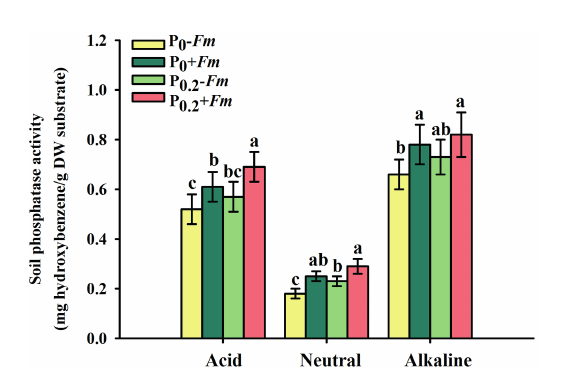
FIGURE 3 Changes in soil phosphatase activities of Polygonum cuspidatum by Funneliformis mosseae and P supply. Data (means ± SD, n = 4) followed by different letters above the bars indicate significant ( p < 0.05) differences among treatments. + Fm , inoculation with F. mosseae ; − Fm , inoculation without F . mosseae ; P 0 , 0 M P; P 0.2 , 0.2 M P; P,